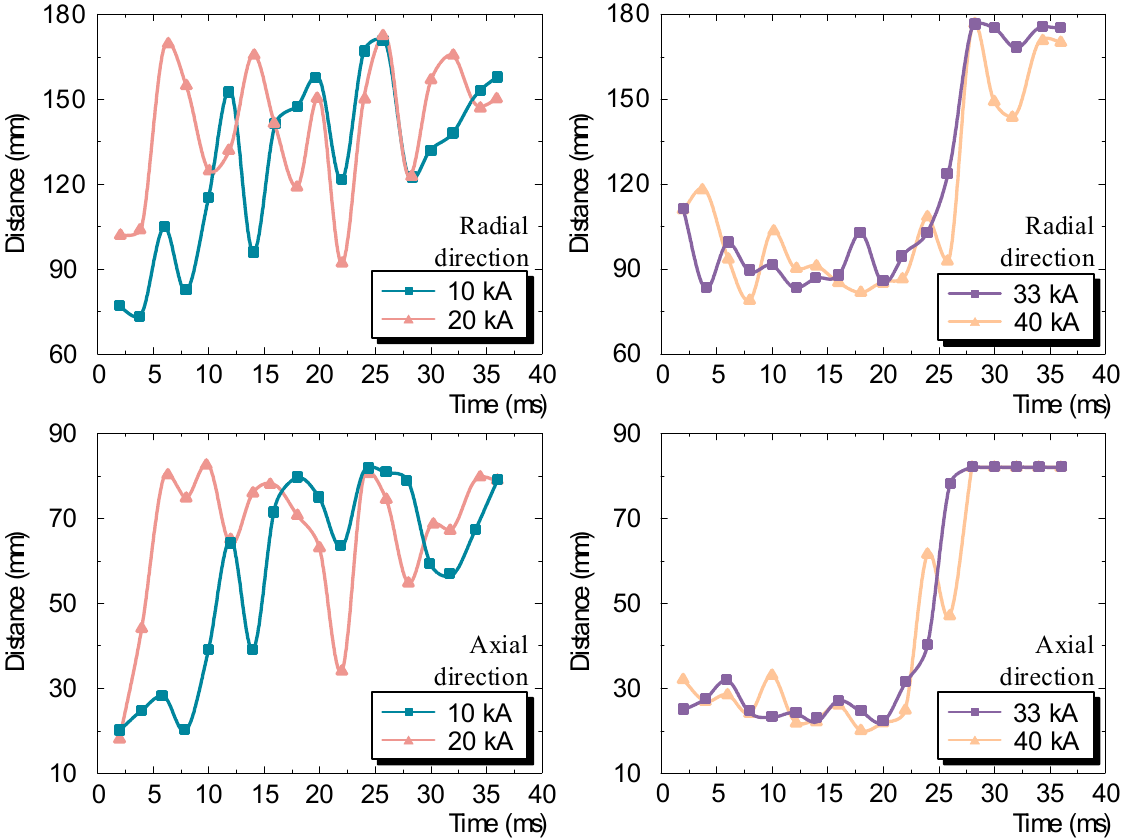
Figure 8. A comparison of arc diffusion under different current levels with a range between 10 kA and 40 kA.